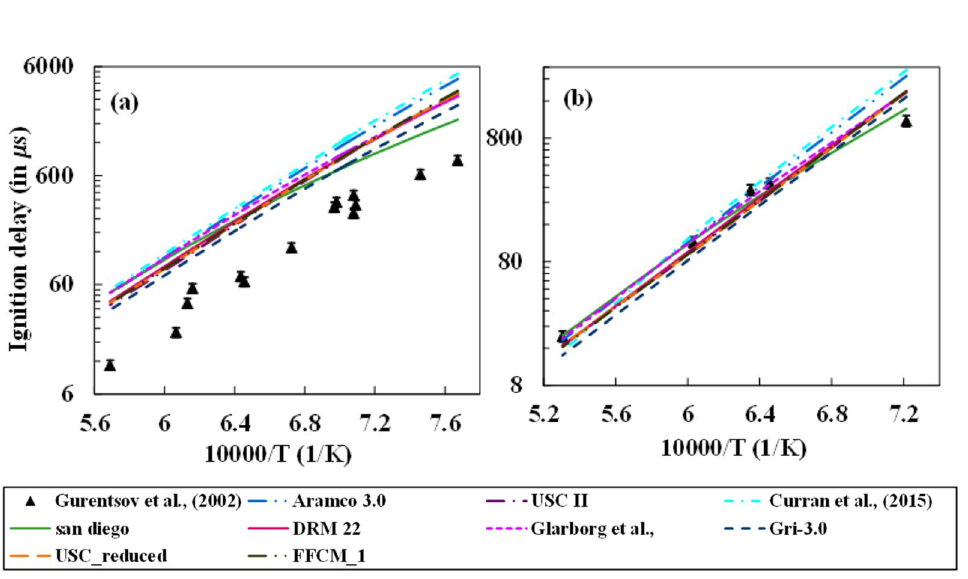
Figure 4. Comparison between different mechanisms for steam dilution with the buffer gases: ( a ) N 2 and ( b ) Ar at different operating conditions 38